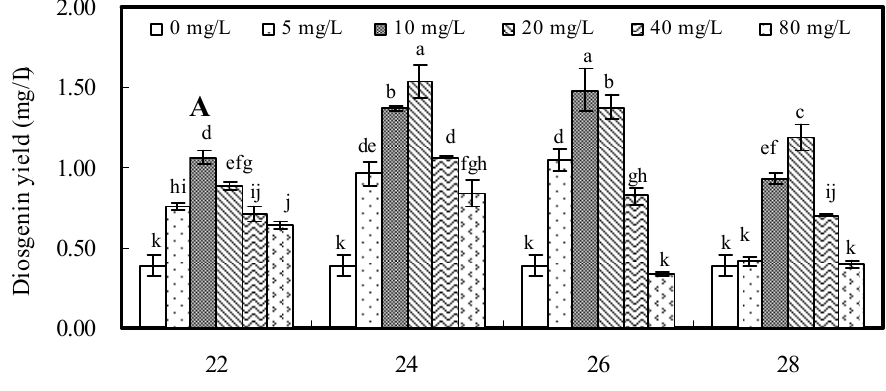
Figure 1. Effects of oligosaccharide fractions DP2-5 ( A ), DP5-8 ( B ) and DP8-12 ( C ) on diosgenin yield of D. zingiberensis cell cultures . The error bars represent standard deviations ( n = 3). Different letters indicate significant differences among the treatments at p = 0.05